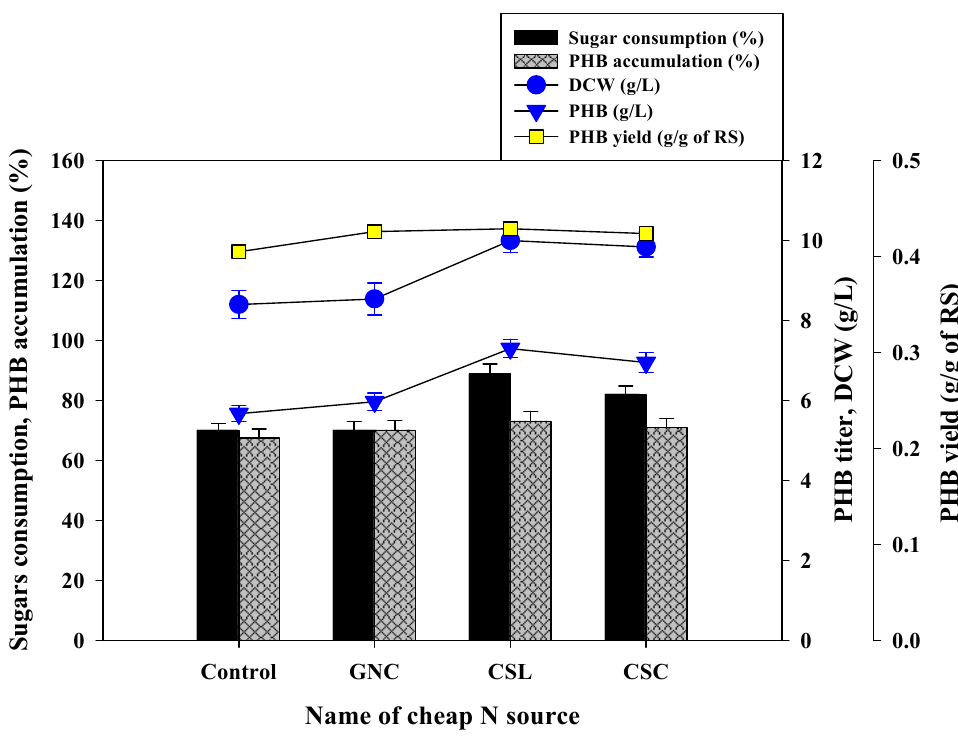
Figure 5. Effects of supplementation of cheap nitrogen sources with NaOH pretreated WH Figure 5. E ff ects of supplementation of cheap nitrogen sources with NaOH pretreated WH enzymatic enzymatic hydrolysates on bacterial cell growth and PHB production. hydrolysates on bacterial cell growth and PHB